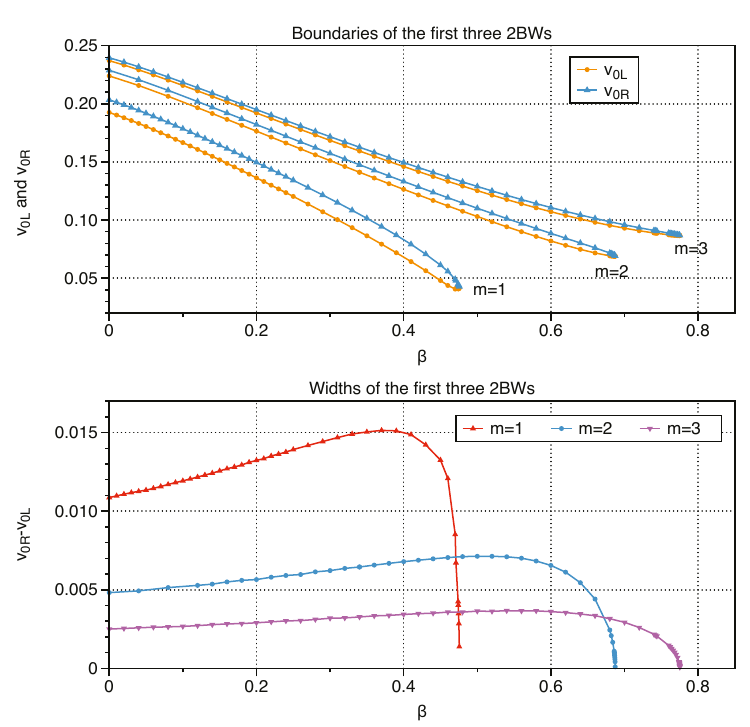
Figure 6 . The boundaries (upper panel) and the widths (lower panel) of the (cid:12)rst three 2BWs (labeled by m = 1 ; 2 ; 3) for n = 1 and (cid:12) 2 [0 ; 0 : 8]. Here the boundaries and the widths are calculated at t = 200. v 0 L and v 0 R are the left and right boundaries of the two bounce windows.